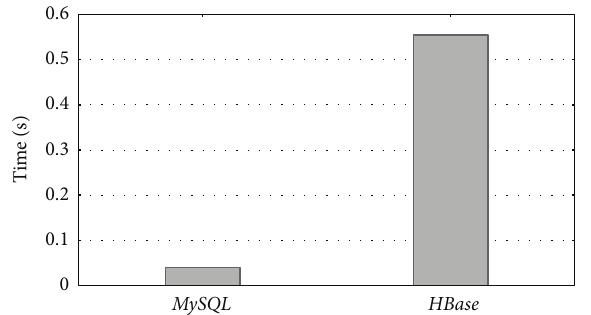
Figure 14: MySQL and MapReduce runtimes when accessing the Processestable